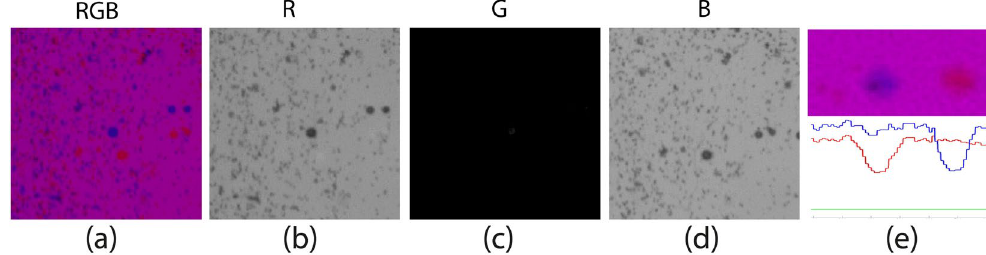
Figure 4. ( a ) Original image using only Red and Blue flashes (obtained with a Nikon sensor). The captured image is separated in its RGB channels red ( b ), green ( c ), and blue ( d ). ( e ) The color intensities cut through the blue and red dots.